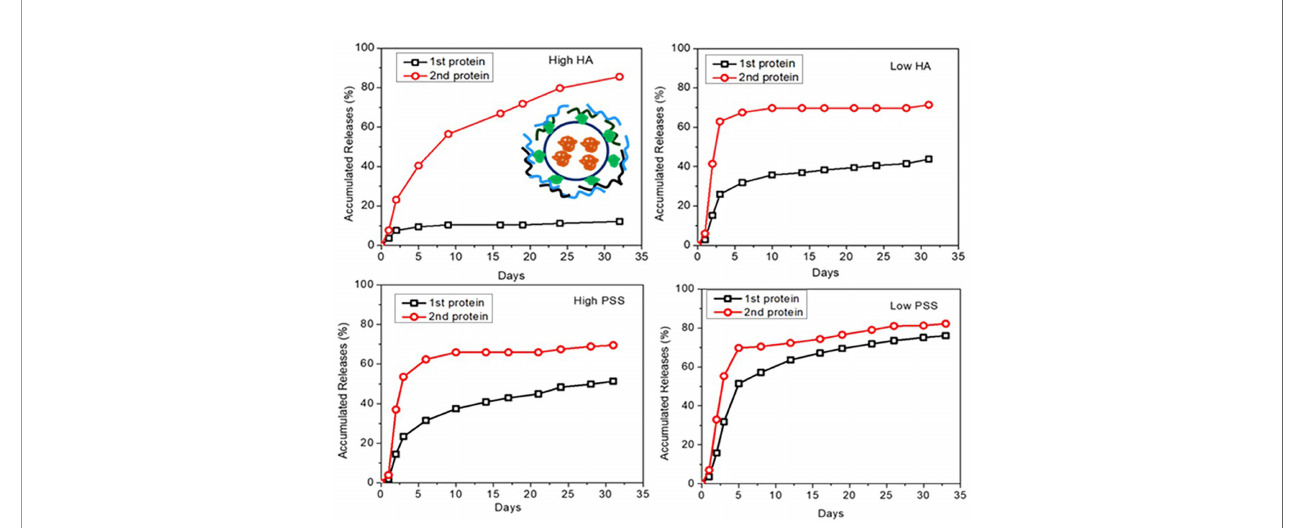
FIGURE 4 | Dye-labelled protein release pro fi les for different formulations of LbL NP by tuning of amount of outside of PSS or HA protective layer (insert is the schematic for two layers of loading of dye labelled proteins by coated with protective